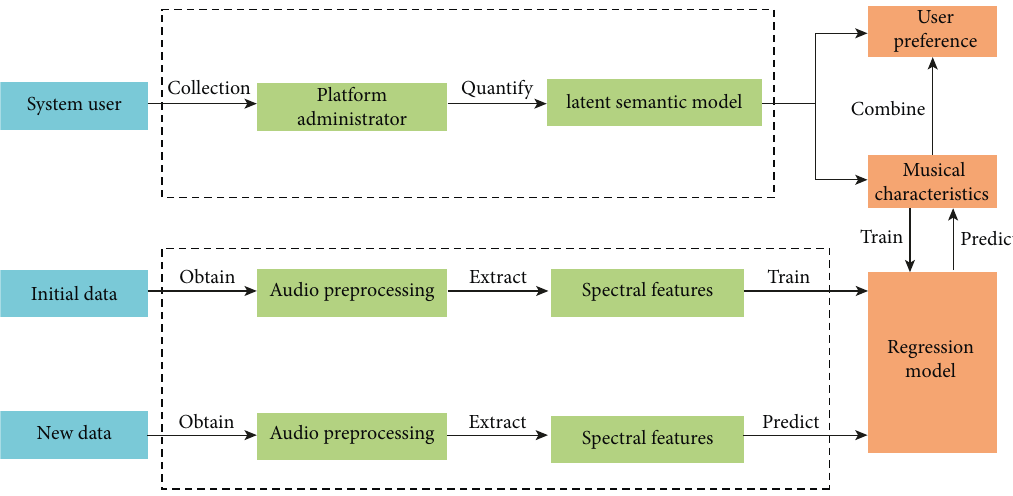
Figure 1: Flowchart of the overall design of the music big data management system for college